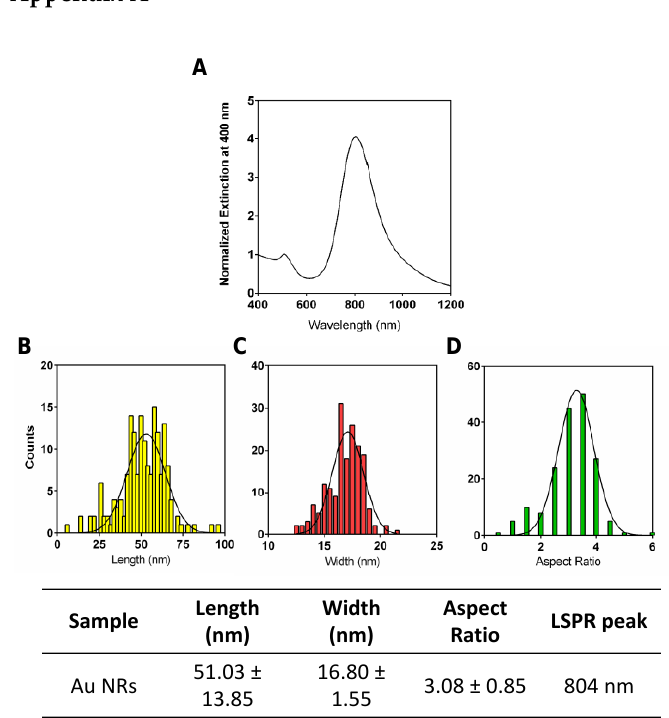
Figure A1. Gold nanorods characterisation. UV-Vis extinction spectra for the gold nanorods ( A ) and histograms of their length ( B ), width ( C ), and aspect ratio ( D ).